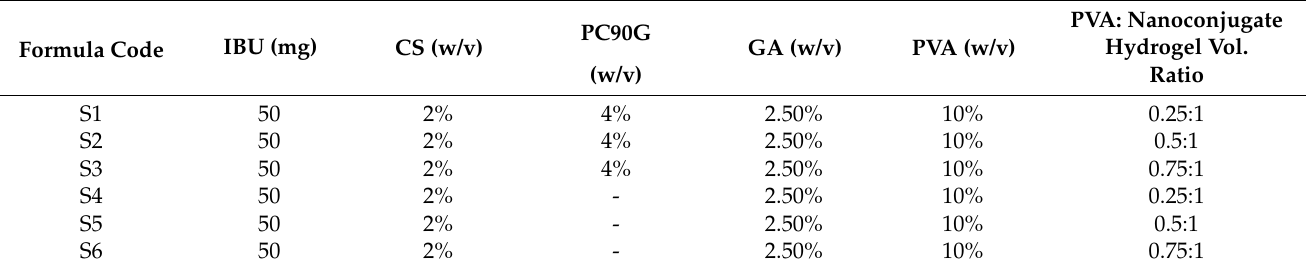
Table 4. Optimisation of the IBU nanoconjugate hydrogels. The variation of components determines the changes in particle size, together with the polydispersity index (PDI) and drug conjugation efficiency.